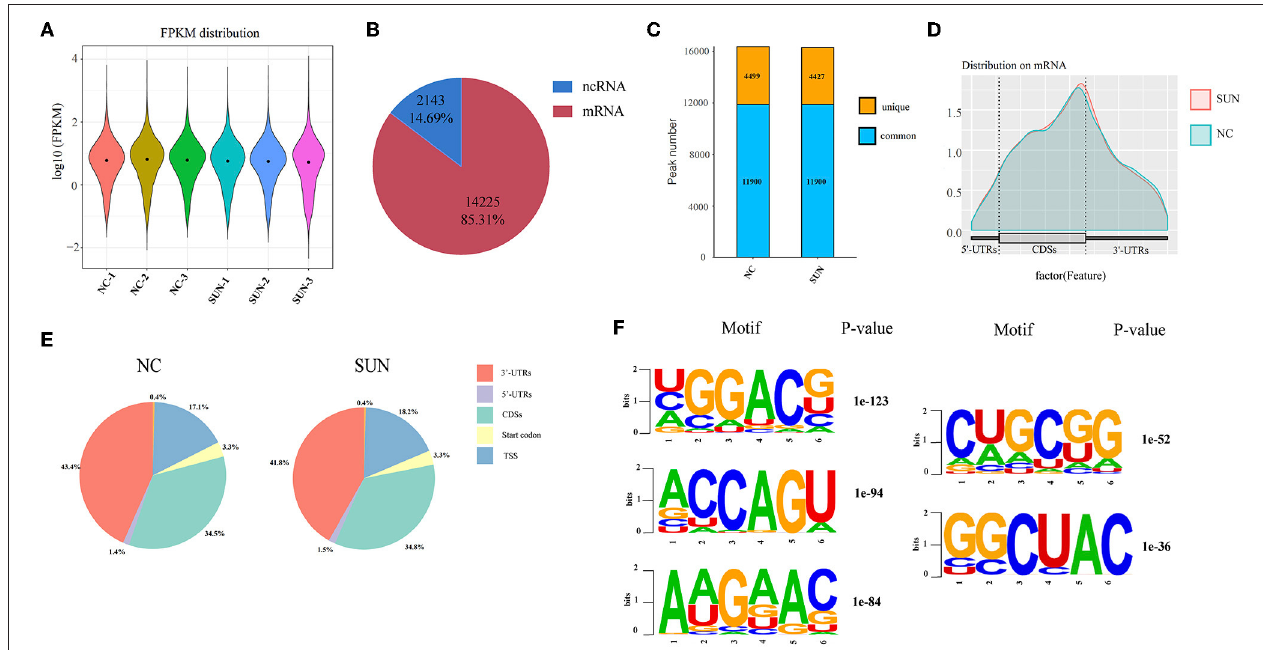
FIGURE 2 | Overview of the m 6 A methylation map in SUN-treated hiPSC-CMs. (A) Sequencing sequences were compared to the genome and the distribution intensity and abundance of normalized expression quantities are described. (B) Pie chart showing the distribution of m 6 A peaks in mRNAs and non-coding RNAs (ncRNAs). (C) The histogram displays the unique and common m 6 A peaks in the two sets of mRNAs. (D) The density curve shows the distribution of the m 6 A peak on the transcript, which is divided into three parts: 5 ′ -UTR, CDSs, and 3 ′ -UTRs. (E) Pie charts showing the proportion of the m 6 A peak distribution in the NC and SUN groups. (F) The top five motifs enriched across the m 6 A peaks. SUN, sunitinib; CDS, coding DNA sequence; UTR, untranslated